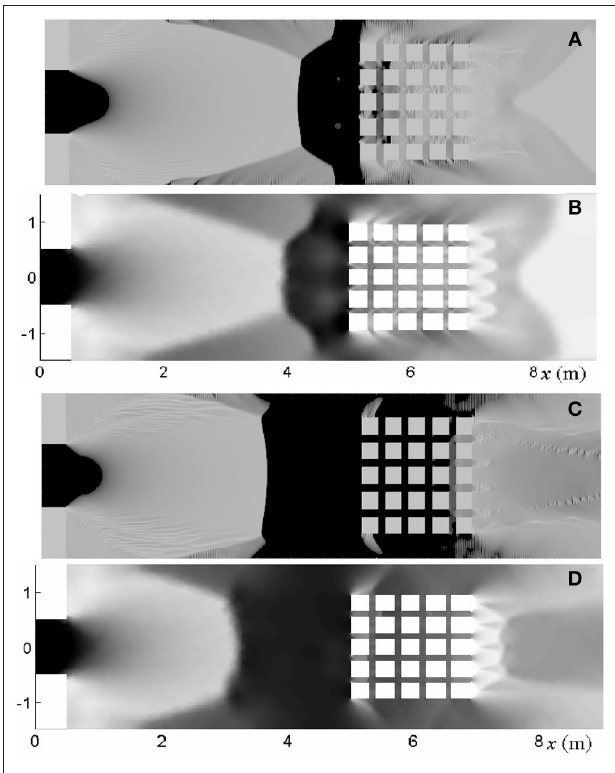
FIGURE 8 | Test case III. Computed water depth map. Darker color for larger depth values. Top panels (A,B) : t = 5 s ; bottom panels (C,D) : t = 10 s . Panels (A,C) : DBE numerical results. Panels (B,D) are numerical values from Soares-Frazão and Zech (2008).